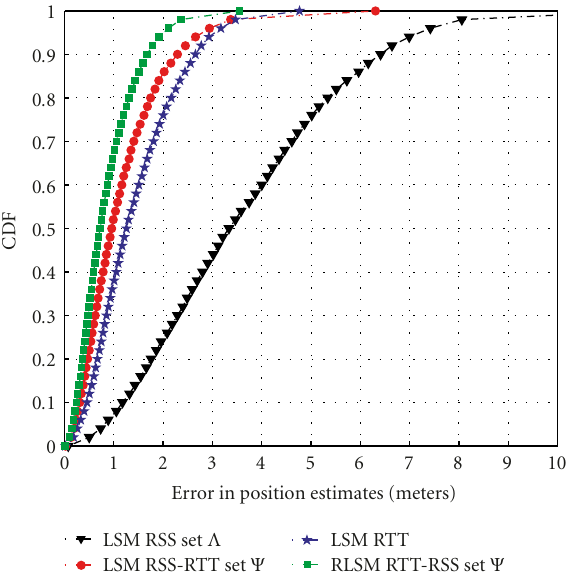
Figure 6: CDFs of errors in position estimation depending on the multilateration method and set of constraints used in the simulation